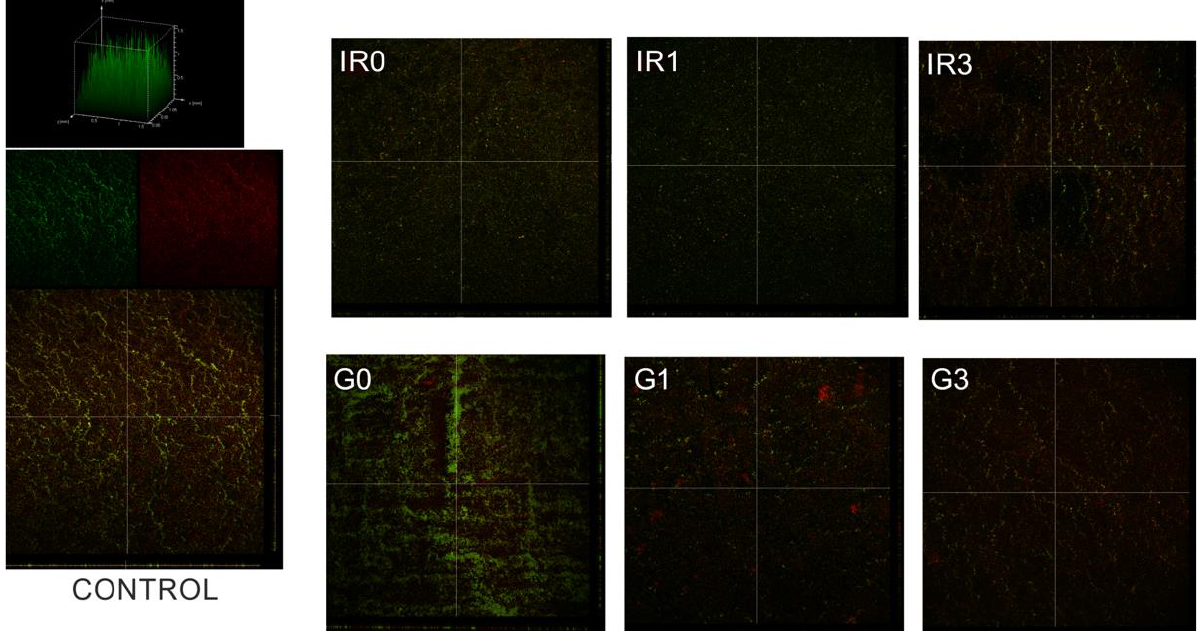
Figure 12. Biofilm inhibition test. Example of the fluorescence CLSM images for Ti surface covered by mixed oral bacteria biofilms for the different types of samples tested. Control sample is the bare titanium disc without Ag-NPs. The other samples correspond to Ti discs with immobilized Ag-NPs obtained according to conditions of Table 3.